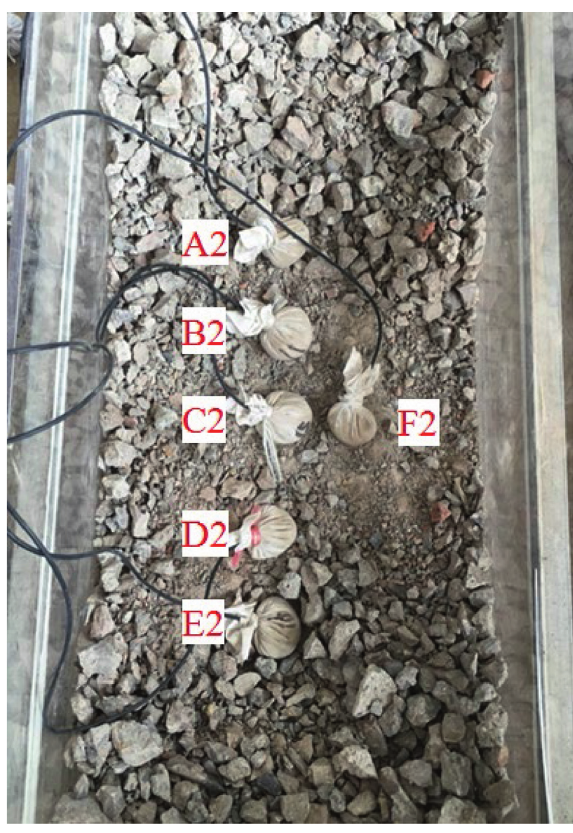
Figure 5: Schematic layout of one-story Earth pressure